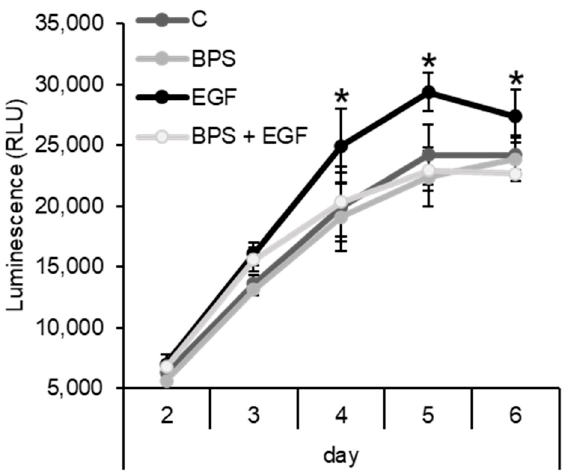
Figure 3. Effect of BPS on HTR-8/SVneo cell proliferation using CellTiter-Glo luminescent cell pro- liferation assay. Quantification expressed as relative light units (RLU) of HTR-8/SVneo cells exposed to 0.1% DMSO (control; C), BPS (1000 ng/mL), EGF (30 ng/mL;), or BPS + EGF (mean ± SEM) treatments. Generalized linear model was used compare treatments. Asterisks denotes statistical differences to the control group at p < 0.05 ( n = 4 technical replicates/group).